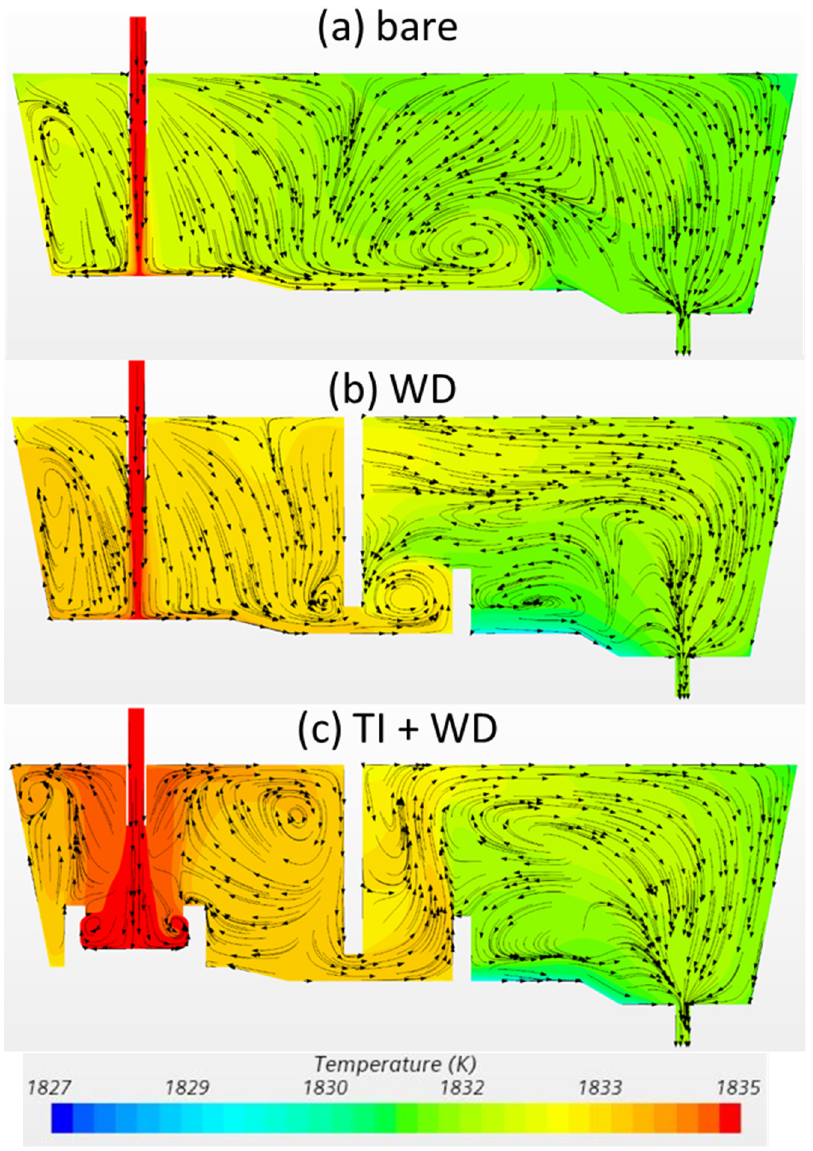
Figure 11. Fluid flow and temperature distributions in tundish for three single-phase cases with different configurations: ( a ) bare; ( b ) WD; ( c ) TI + WD.